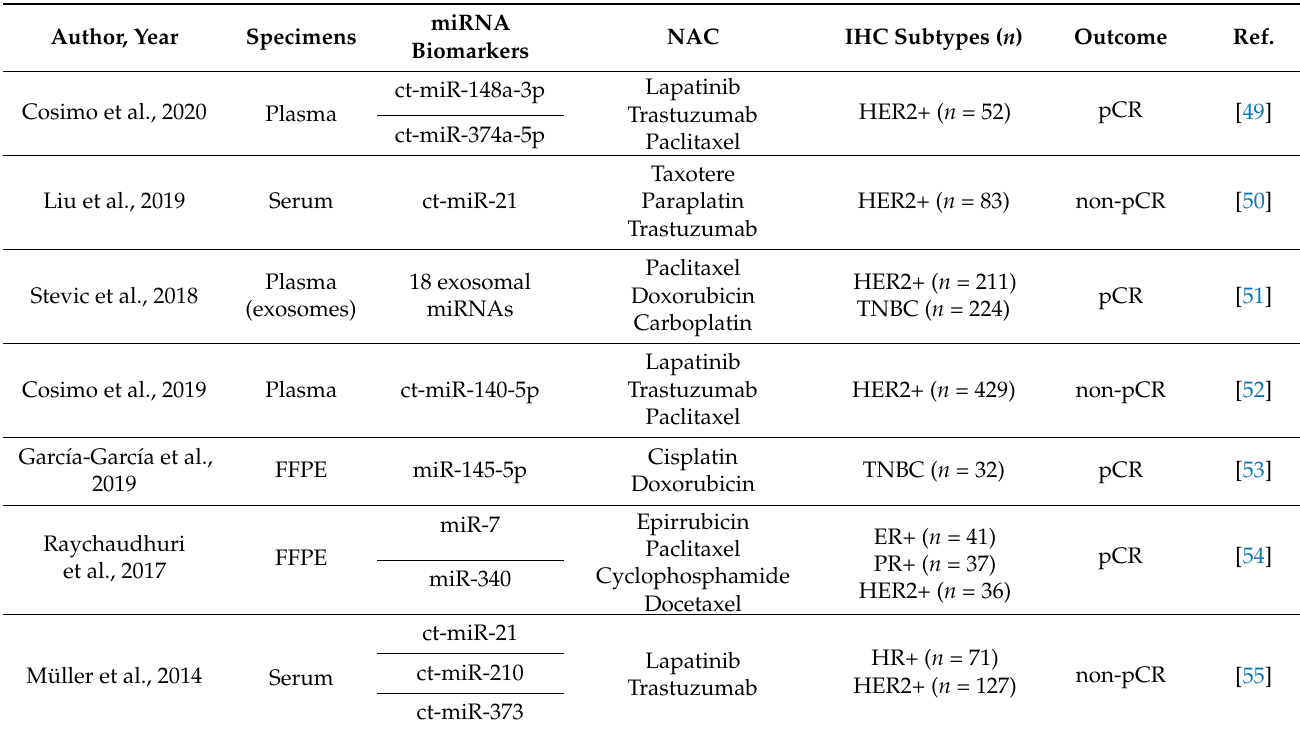
Table 4. miRNAs as biomarkers of pCR or non-pCR after NAC in BC